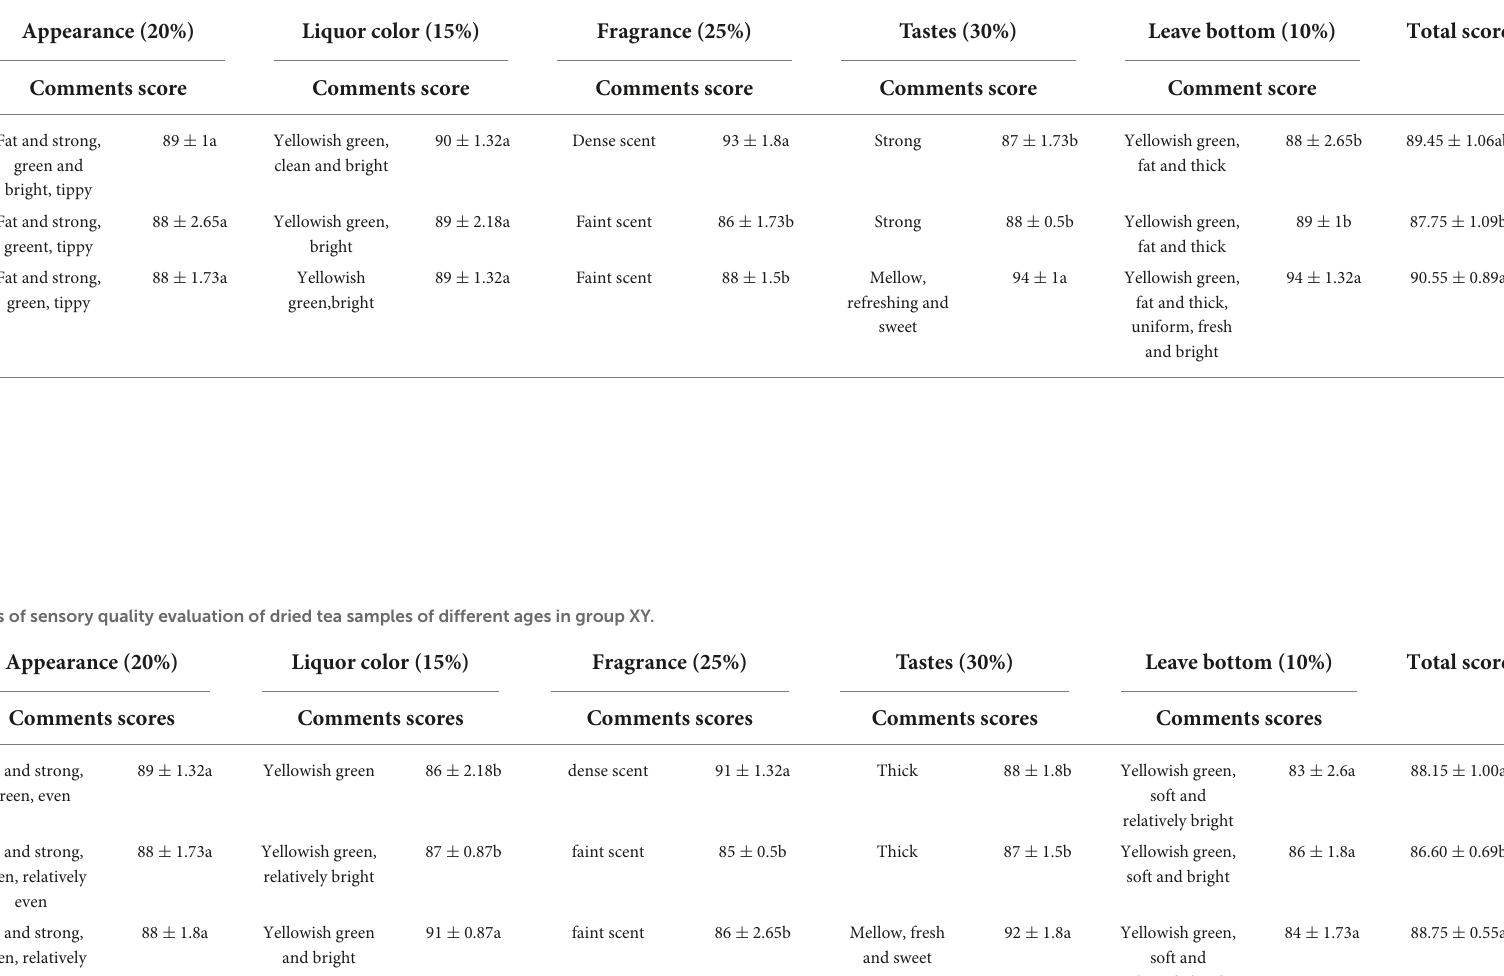
TABLE 4 Results of sensory quality evaluation of dried tea samples of different ages in group JP.